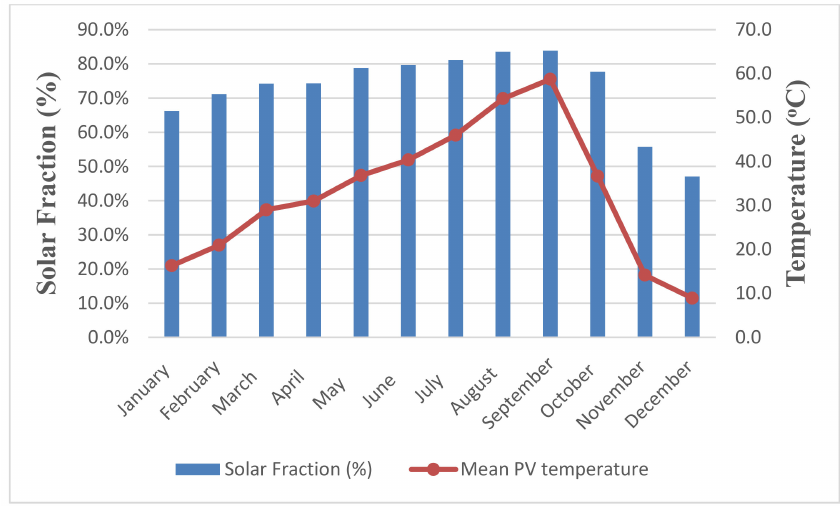
Figure 12. Maximum PV panel surface temperature of the MCPVT-HP system with 90 ◦ tilt angle and 250 kg/h flow rate vs the solar fraction.